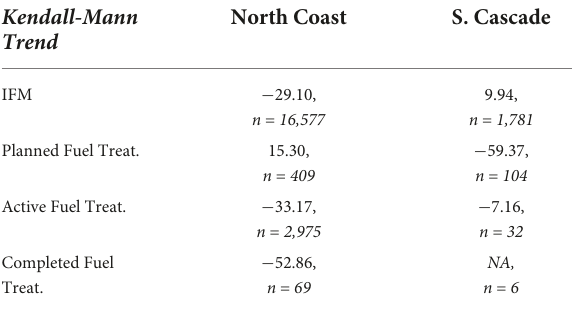
TABLE 2 Average Kendall-Mann Trend in vegetation and the number of samples within each of the categories. Kendall-Mann Trend IFM − 29.10,